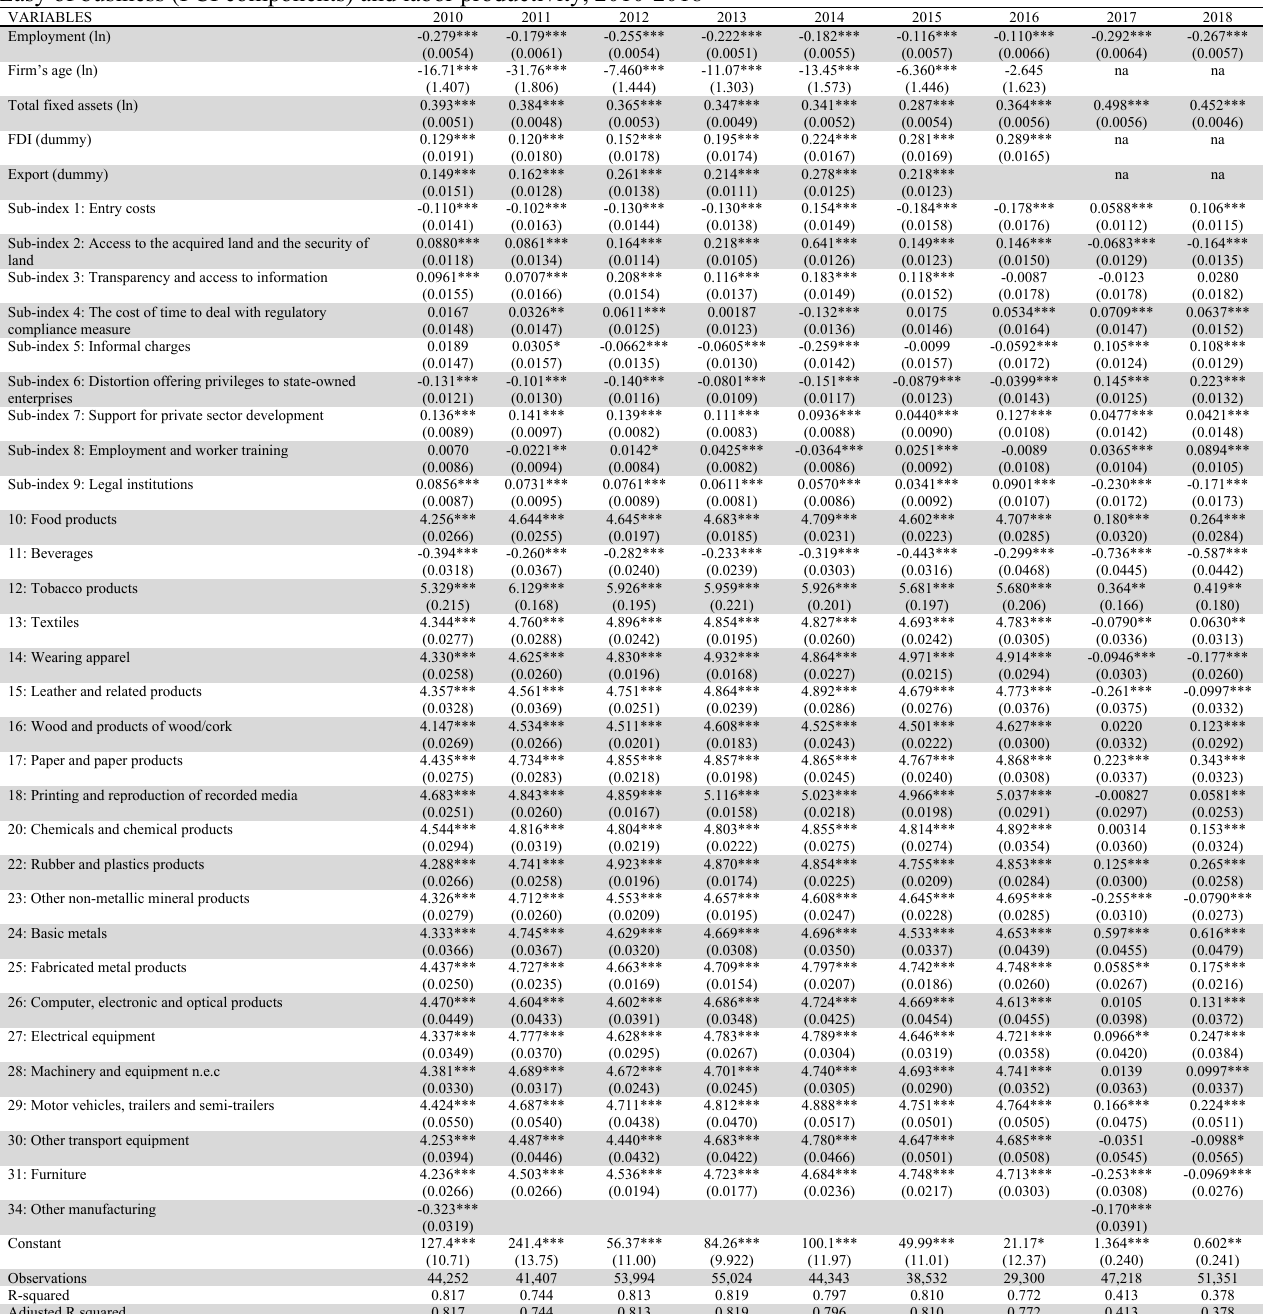
Easy of business (PCI components) and labor productivity, 2010-2018